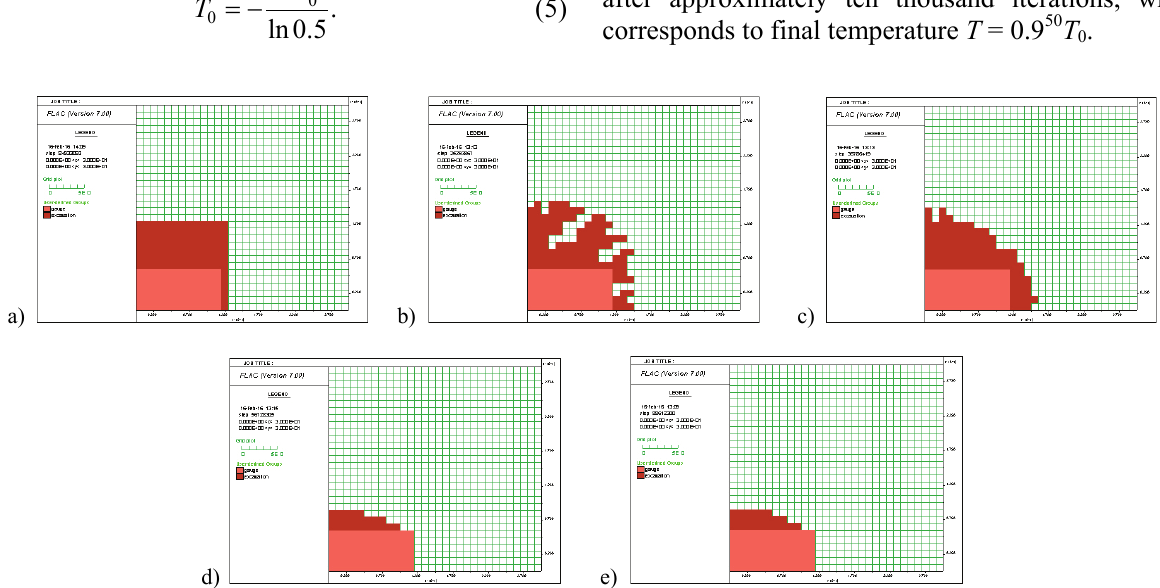
Fig. 3. Evolution of the shape of excavation during the simulated annealing procedure: